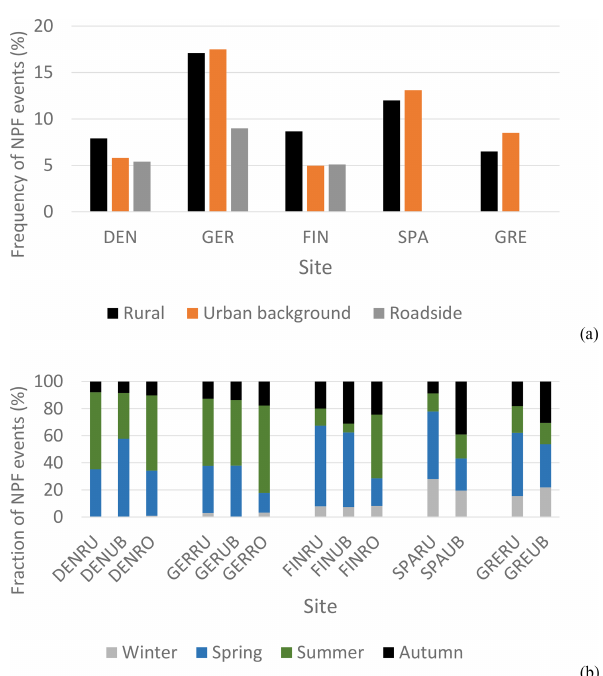
Figure 2. Frequency (a) and seasonal variation (b) of new particle formation events (winter – DJF; spring – MAM; summer – JJA; autumn – SON).